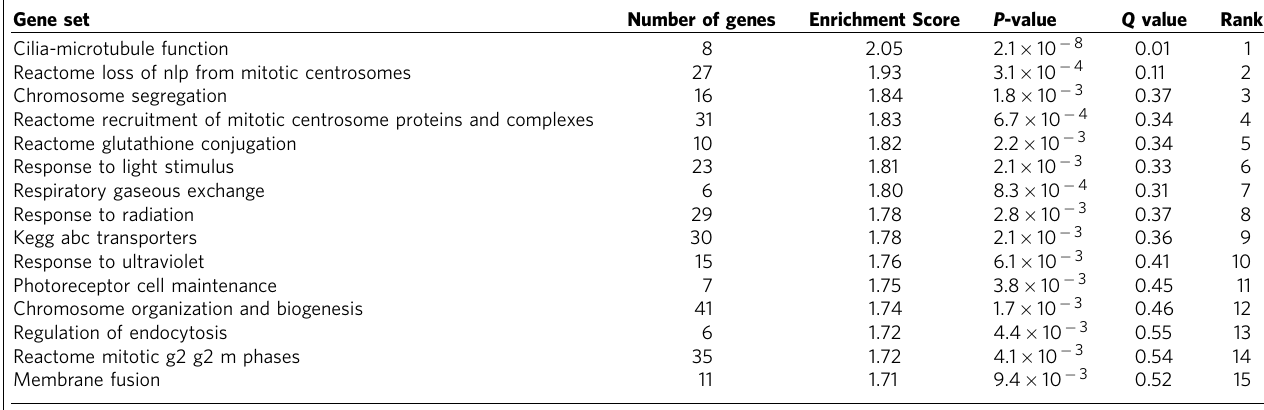
Table 2 | Gene set enrichment analysis results in familial TGCT data set. Gene